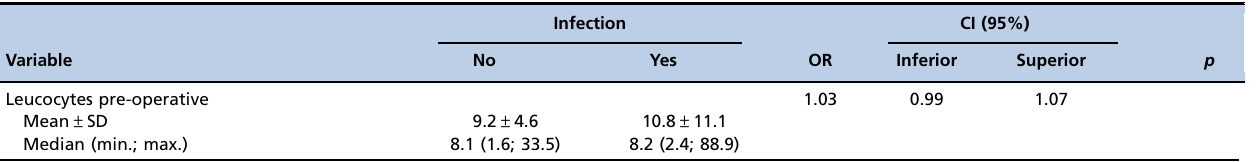
Table 3 - Joint model of the selected variables to explain the occurrence of postoperative infection.